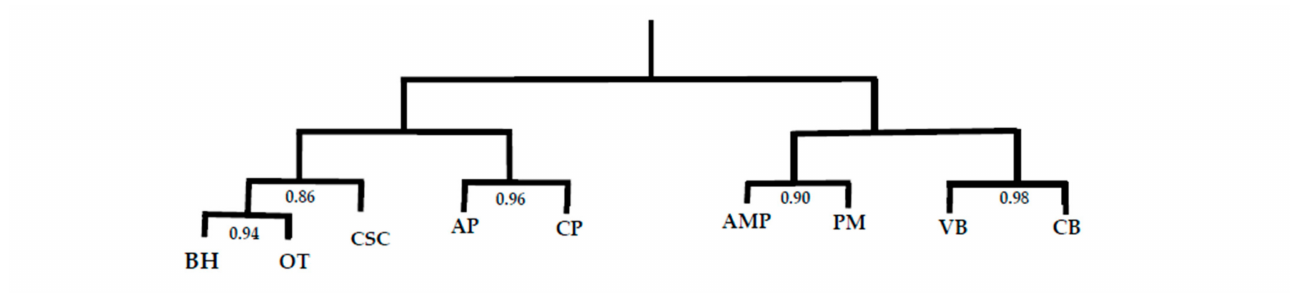
Figure 3. Dendrogram nodes clustered by words’ similarity. Source: Own elaboration.